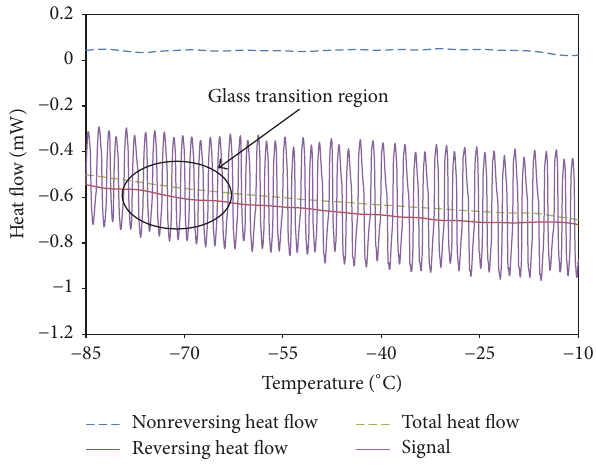
Figure 4: TOPEM DSC curves for